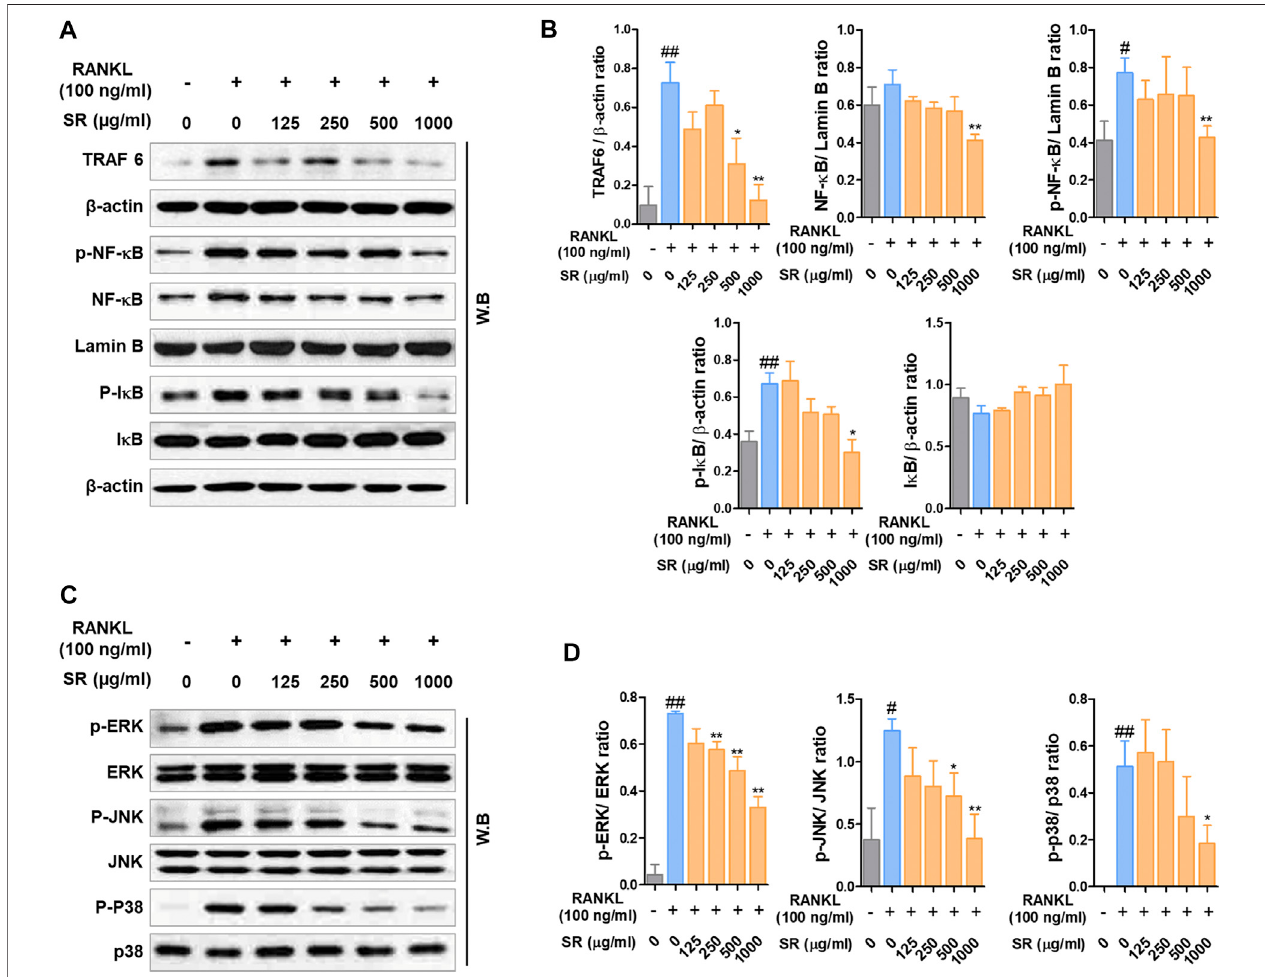
FIGURE 3 | The effects of SR on the expression of TRAF6, NF- κ B and MAPK signaling pathway. (A) Protein expression levels of TRAF6, p-NF- κ B, NF- κ B, p-I κ B andI κ Bweremeasuredbywesternblotting. (B) TRAF6,p-I κ BandI κ Bwerenormalizedtothatof β -actin,whichwasusedasaloadingcontrol.p-NF- κ BandNF- κ Bwere normalizedtothatofLaminB,whichwasusedasaloadingcontrol. (C) Proteinexpressionlevelsofp-ERK,p-JNK,p-p38weremeasuredbywesternblotting.Thebands were normalized to that of ERK, JNK and p38. Data are presented as the mean ± SD of three independent experiments. Statistical analysis was performed using one-way ANOVA followed by Dunnett ’ s post hoc test. # p < 0.05, ## p < 0.01 vs. the normal group (untreated cells); * p < 0.05, ** p < 0.01 vs. the RANKL only treatment